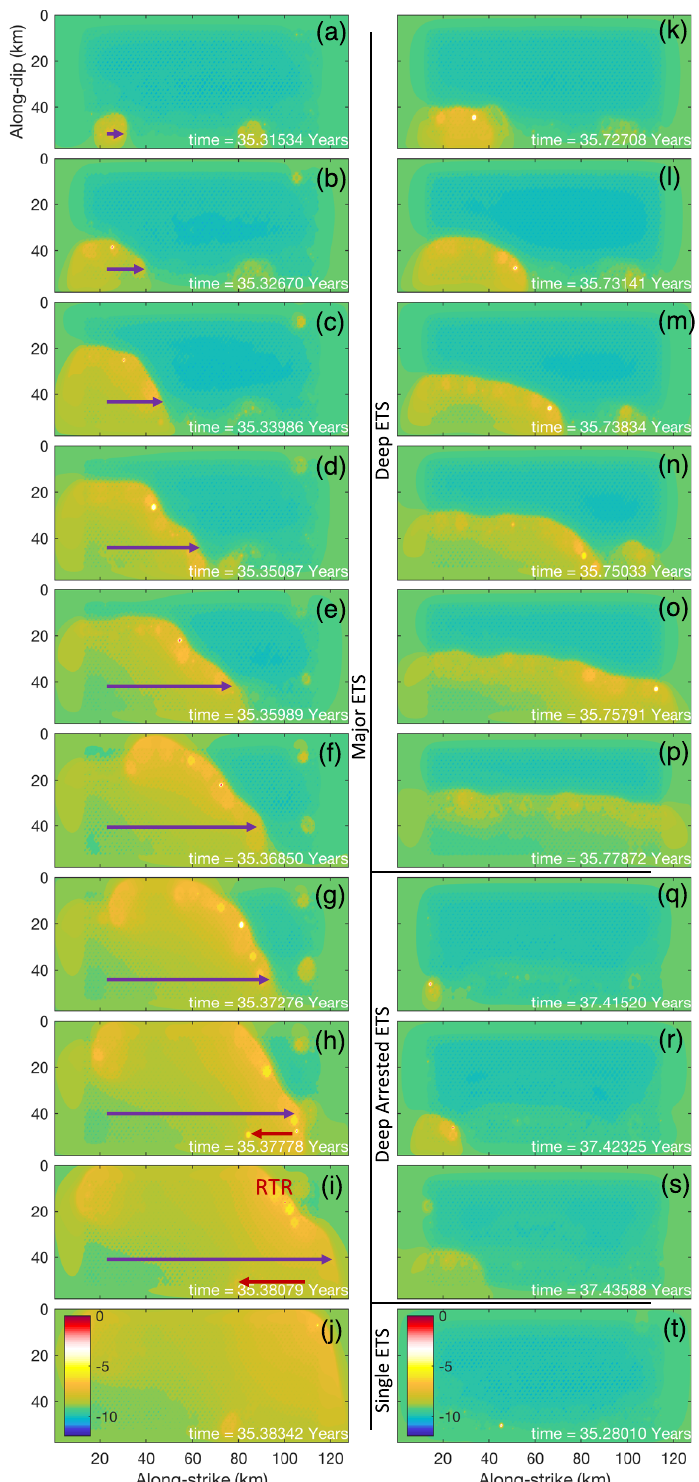
Fig. 7 Snapshots of modeled episodic tremor and slow-slip (ETS) variability. Color shows logarithmic slip rate ( V : m (cid:2) s (cid:3) 1 ): blue, (locked); turquoise: V ’ V (creeping around plate loading rate); yellow: slow-slip; white-red: tremor (seismic, V > 10 4 V V < tectonicloadingrate V pl pl Purple arrow shows ETS forward migration. Red arrow shows a plausible example of rapid tremor reversal. Snapshots of a – j time evolution of a major ETS, k – p a deep ETS, q – s a deep arrested ETS, and t individual